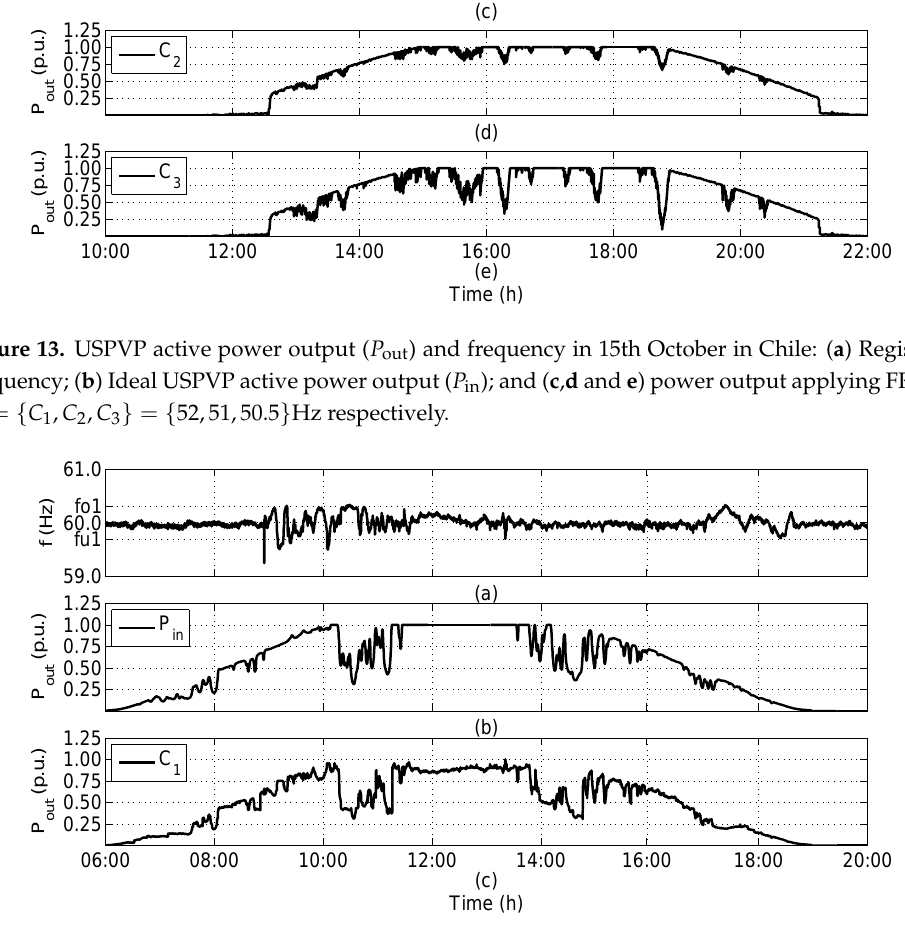
Figure 14. USPVP active power output ( P out ) and frequency in 19th July in Puerto Rico: ( a ) Registered frequency; ( b ) Ideal USPVP active power output ( P in ); and ( c ) power output applying FR ( C 1